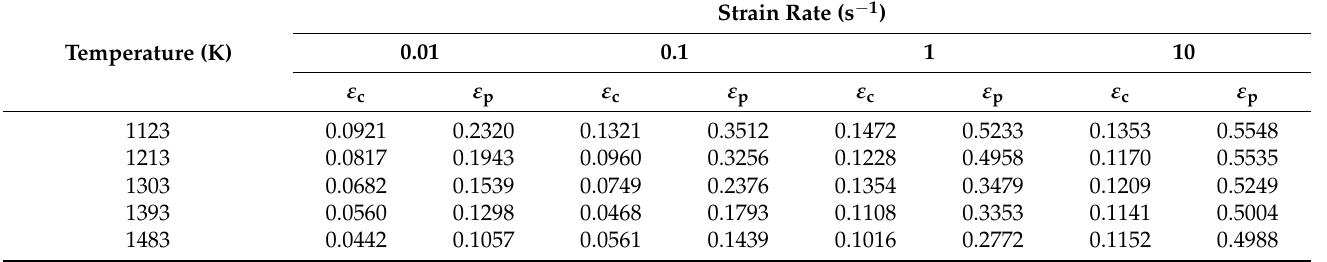
spond to the critical condition for the initiation of DRX.